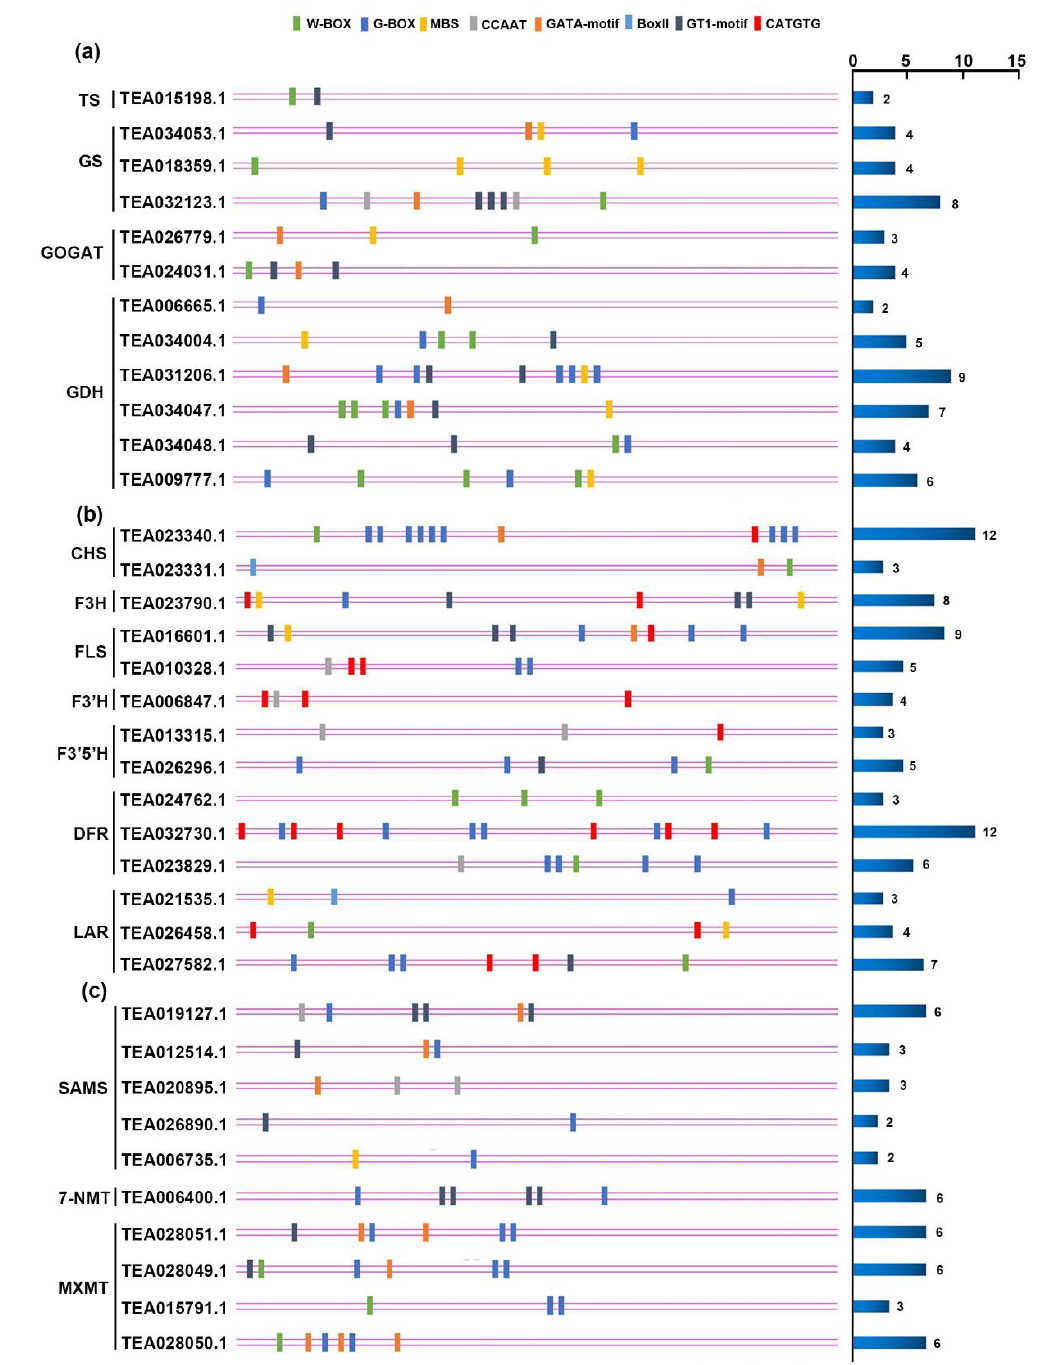
Figure 8. The cis-element of gene promoters in the catechin, L -theanine, and caffeine biosynthesis pathways. ( a ) The cis-element of promoters of differentially expressed genes in the catechin biosynthetic pathway. ( b ) The cis-element of promoters of differentially expressed genes in the L - theanine biosynthetic pathway. ( c ) The cis-element of promoters of differentially expressed genes in the caffeine biosynthetic pathway. The color of bar on the left represents different cis-elements bound by special transcription factor families, and the horizontal column on the right represents the total number of cis-elements of each gene.